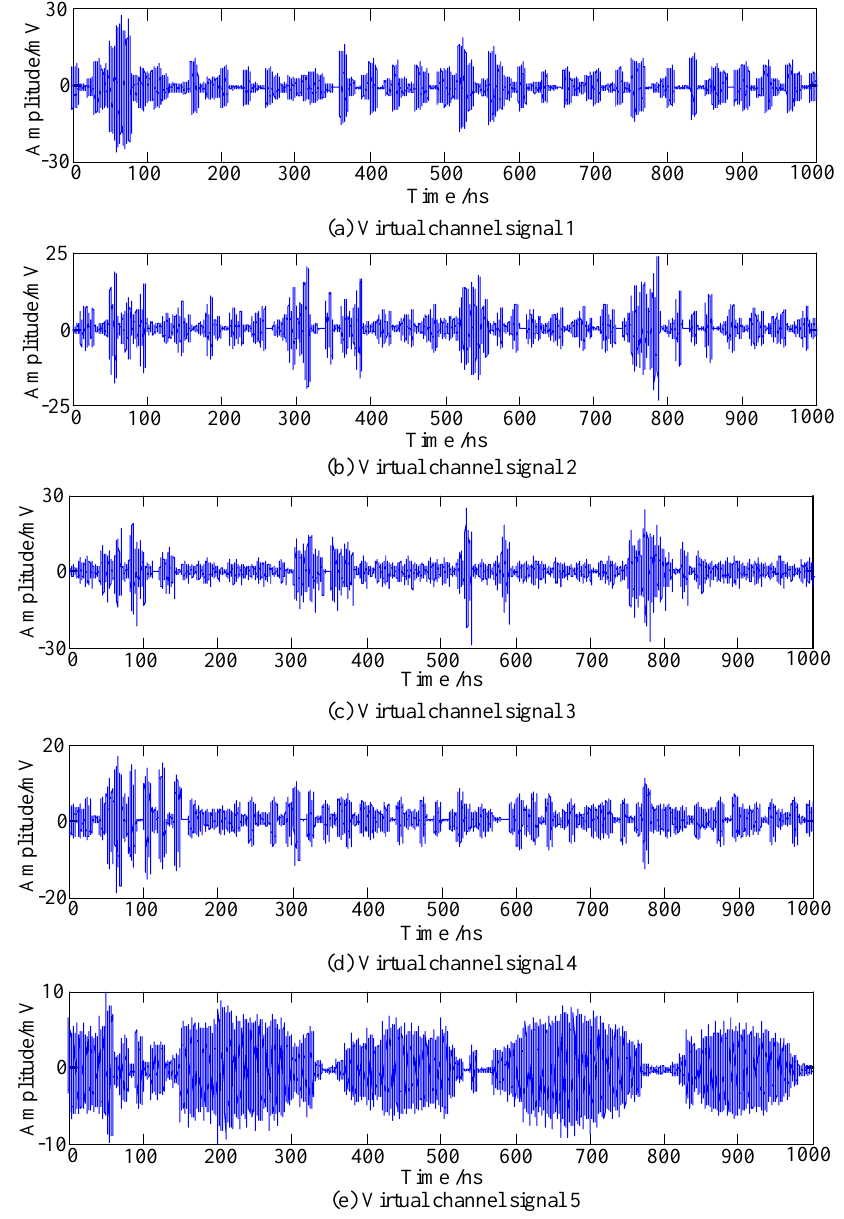
Figure 8. Reconstructed virtual channel signals.